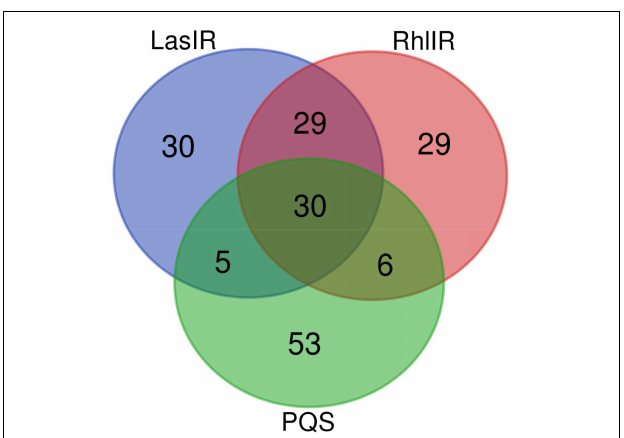
FIGURE 2 | Number of transcriptomic studies affecting QS in P. aeruginosa PAO1. The figure was made using online server at http://bioinformatics.psb.